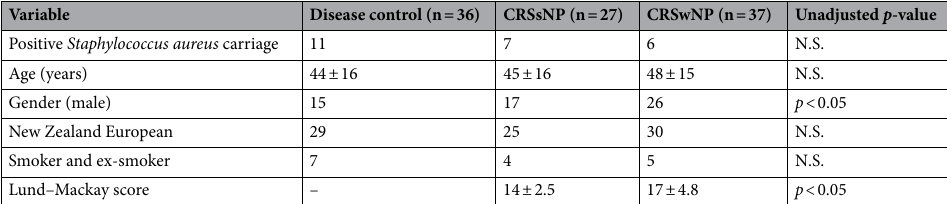
Table 1. Demographic and clinical characteristics on the full cohort of sampled participants in this study (n = 100). CRSsNP chronic rhinosinusitis without nasal polyposis, CRSwNP chronic rhinosinusitis with